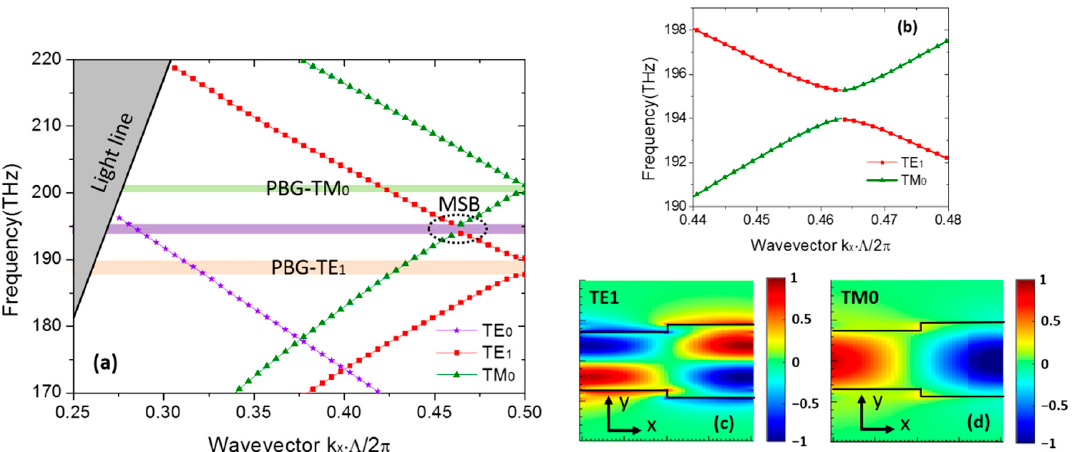
Figure 2. ( a ) Photonic band structure of uniform MWG. ( b ) Local picture of MSB associated to the coupling of TM 0 mode and TE 1 mode. Electric field patterns associated to ( c ) TE 1 mode (y-component, E y ) and ( d ) TM 0 mode (z-component, E z ).